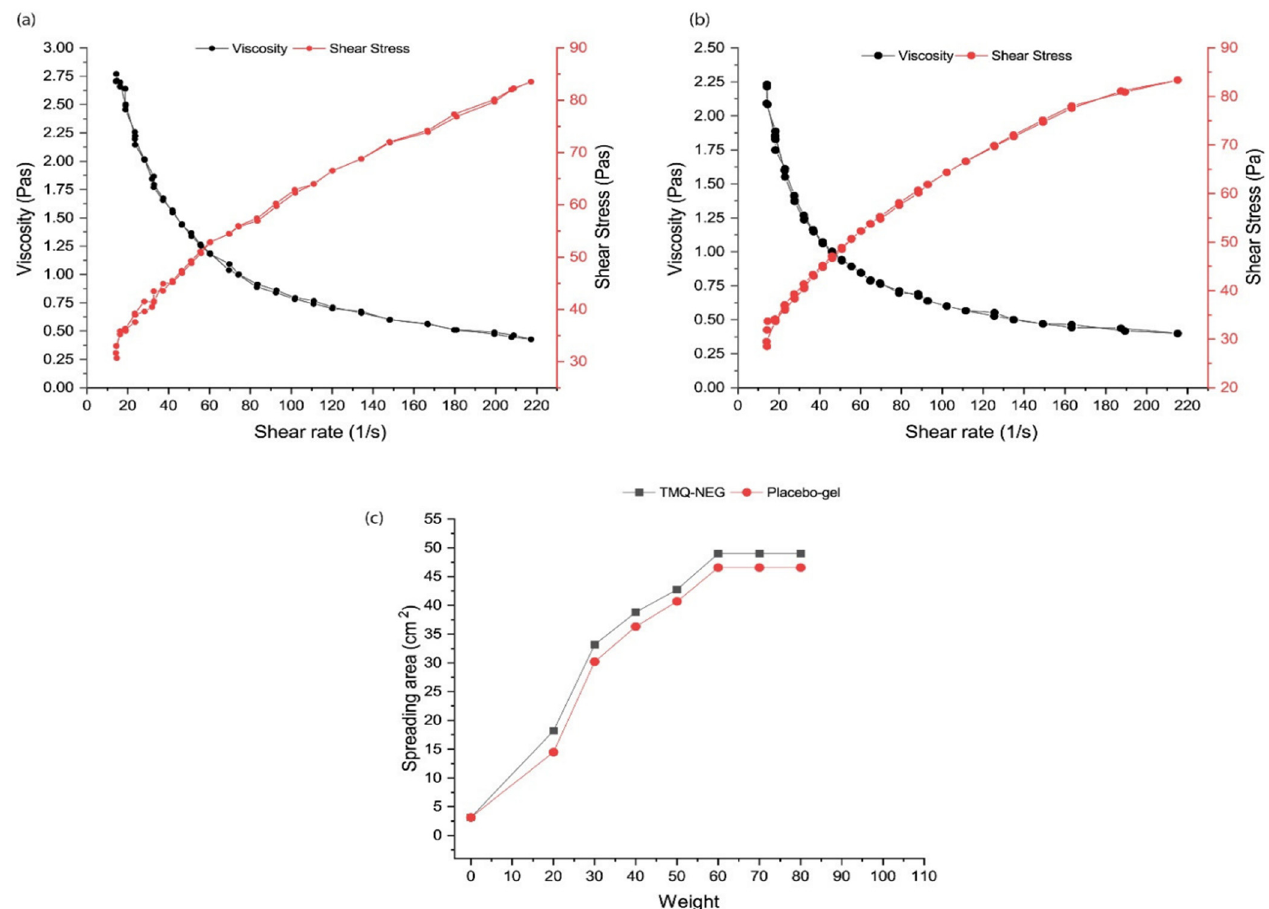
Figure 3. Characteristics of thymoquinone-containing nanoemulgel (TMQ-NEG) system vs. placebo gel. ( a ) Rheology profile of TMQ-NEG system. ( b ) Rheology profile of placebo gel. ( c ) Spreadability behavior of TMQ-NEG vs. placebo gel. Reproduced from [45], Copyright 2021,